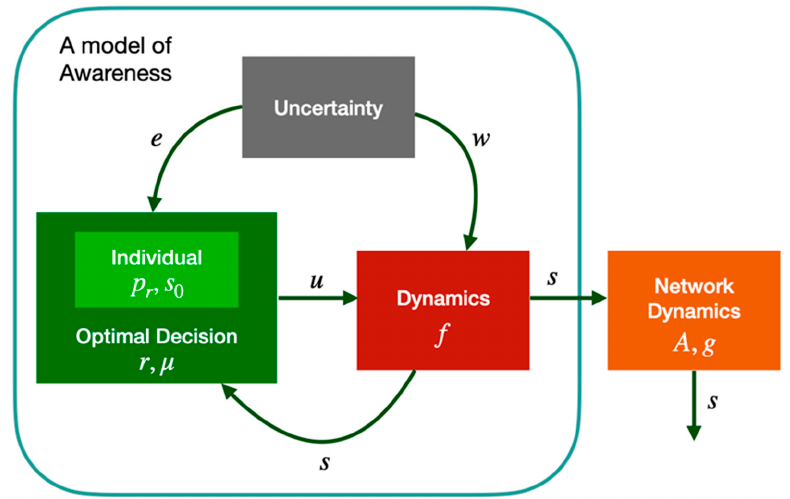
Figure 1. Pictorial representation of the model of awareness. The main elements of the mathematical model are: 1. The individual characteristics (light green box) consisting of the awareness state 𝑠 , the reasoning propensity 𝑝 (cid:3045) , and the initial level of awareness 𝑠 (cid:2868) ; 2. The optimization process (dark green box) defined by the reward function 𝑟 , and the optimal policy 𝜇;3. The awareness dynamics (red box) determined by the action 𝑢 , the sources of uncertainties 𝑒 and 𝑤 (gray box), and the transition function 𝑓 ; 4. The effect of the interconnection with others (orange box), where 𝐴 is the adjacency matrix of the graph and 𝑔 is the interaction function.